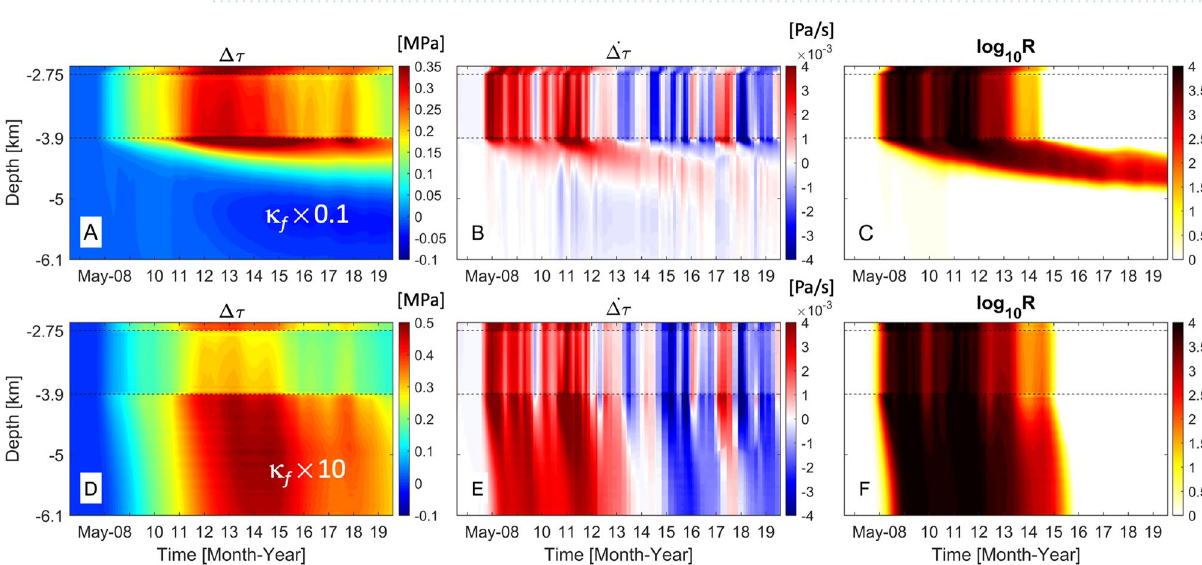
2.49 10 − 15 m 2 ) ( B ) less permeable fault ( κ f = × 2.49 10 − 14 m 2 ). = ×